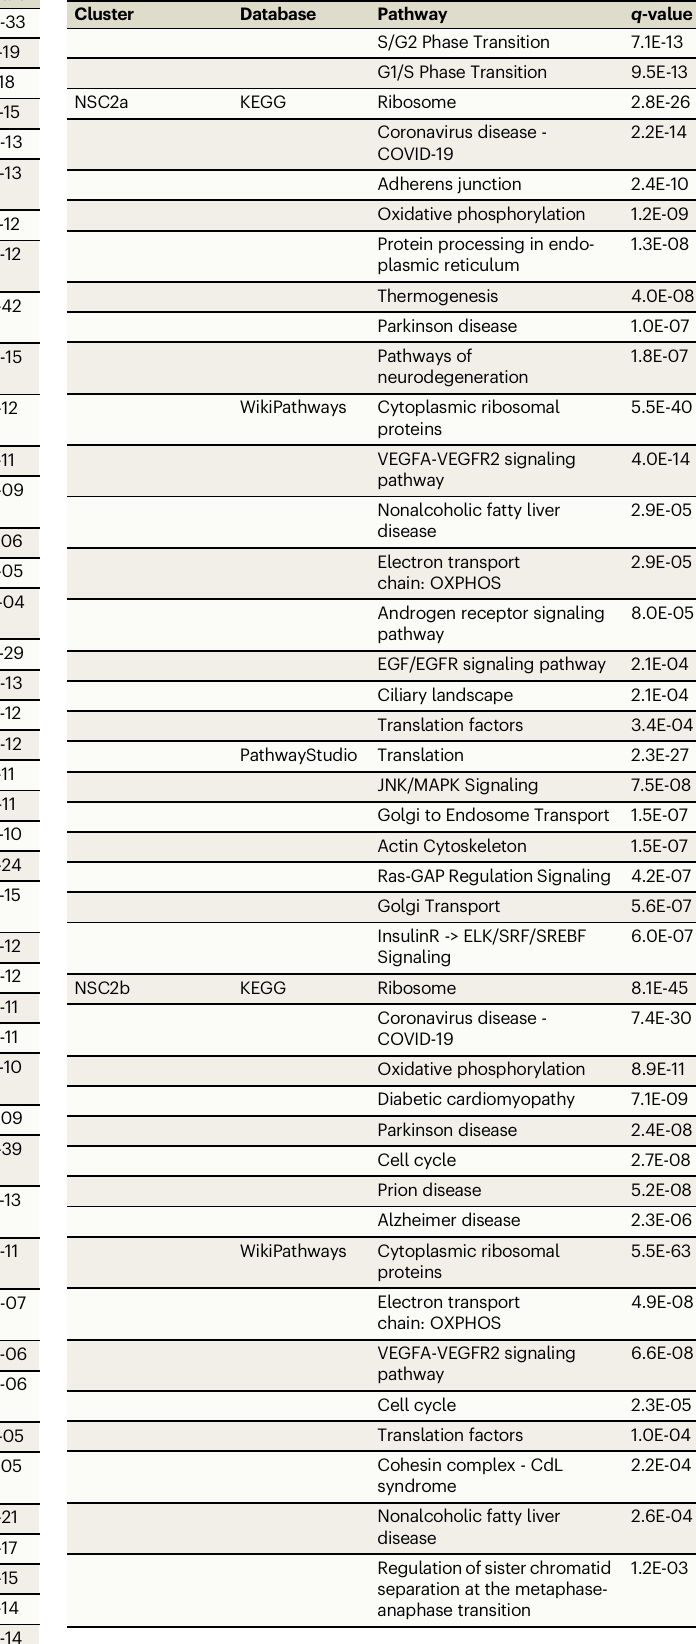
Table 1 | Top 8 pathways signi fi cantly enriched in sPD Cluster